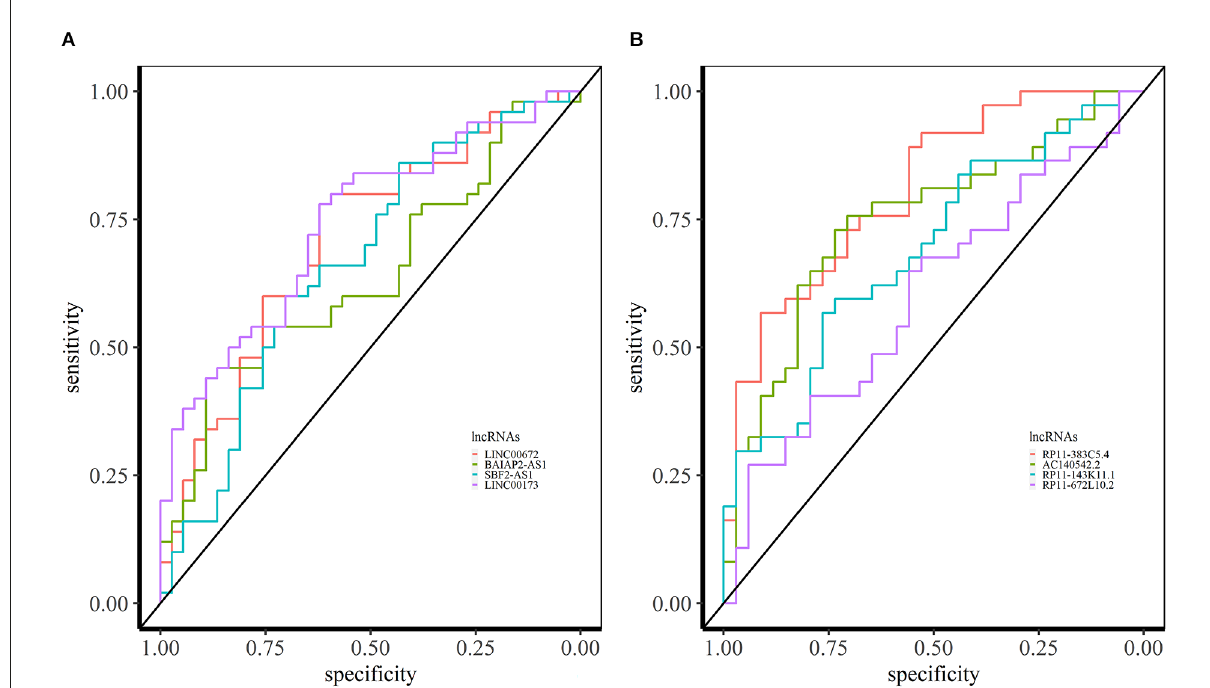
FIGURE7 ROC analysis based on lncRNA expression in SCZ and BD. (A) ROC curves of LINC00672, BAIAP2-AS1, SBF2-AS1, and LINC00173 in BrainGVEX SCZ patients. (B) ROC curves of lncRNAs with AUC > 0.6 in BrainGVEX BD